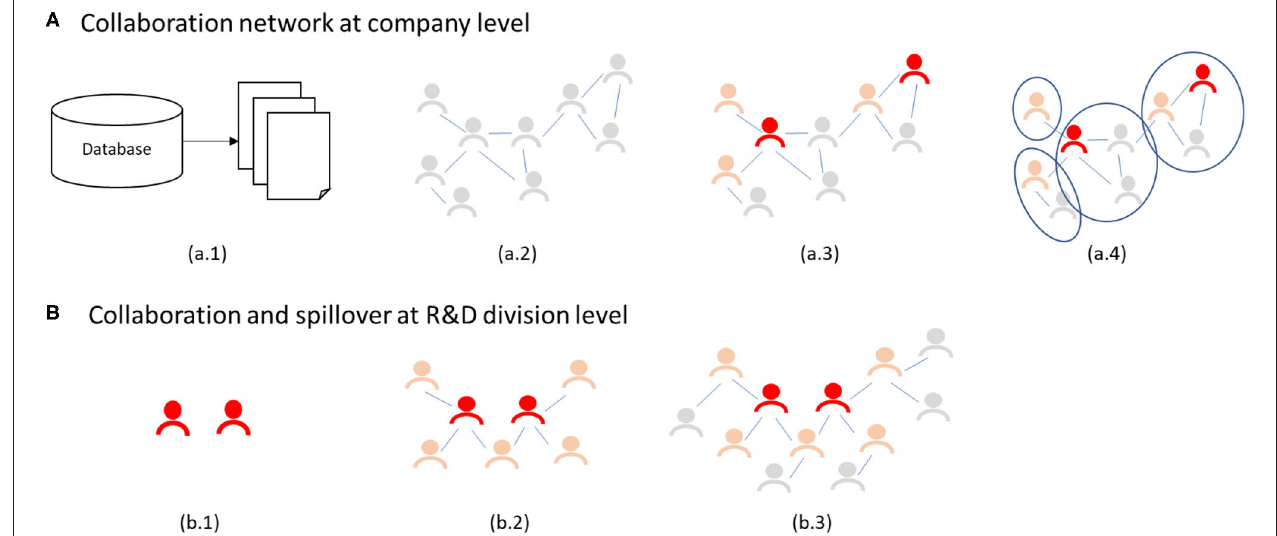
FIGURE 2 | The methodological approach in this research. At the company level patents are extracted from a patent database (a.1) ; a network of inventors is created where 2 inventors are connected if they co-invented a patent (a.2) ; start researchers and other highly achieved researchers are identified and their characteristics studied with binomial logistic regression (a.3) ; clusters of inventors are obtained and analyzed. At the R&D level, a subset of star researchers that worked in the same division was identified (b.1) ; direct collaborators and second level collaborators were identified (b.2, b.3) ; and their career characteristics were